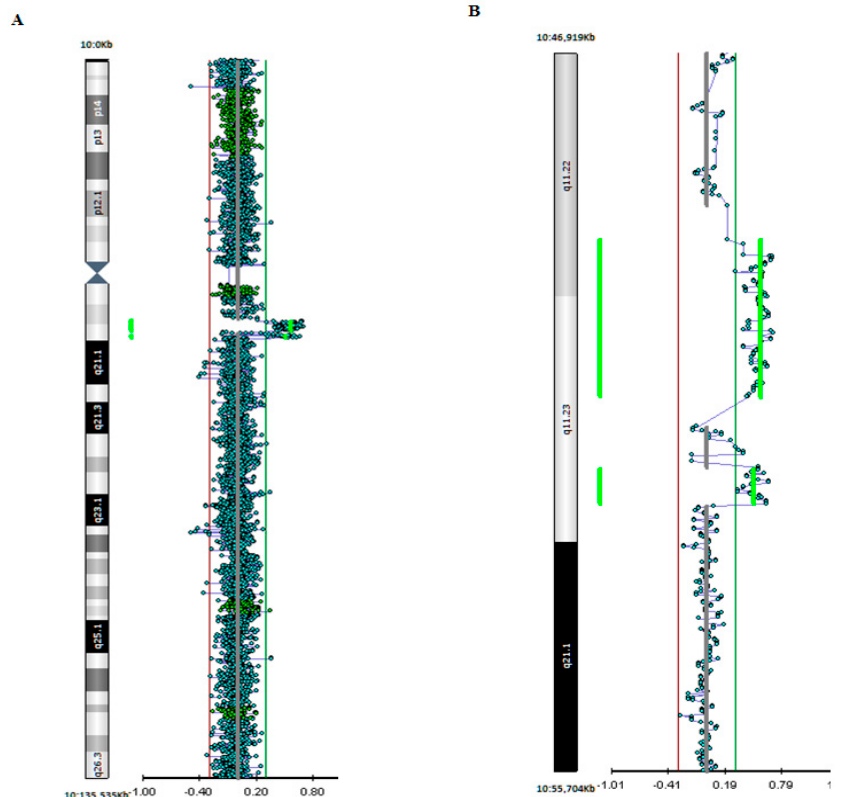
Figure 1. Array-CGH profile showing the 10q11 duplications detected in our patient. ( A ) View of the whole chromosome 10 and of the chromosomal region involved in the duplication. ( B ) Enlarged view showing the two adjacent duplications on 10q11.22q11.23.